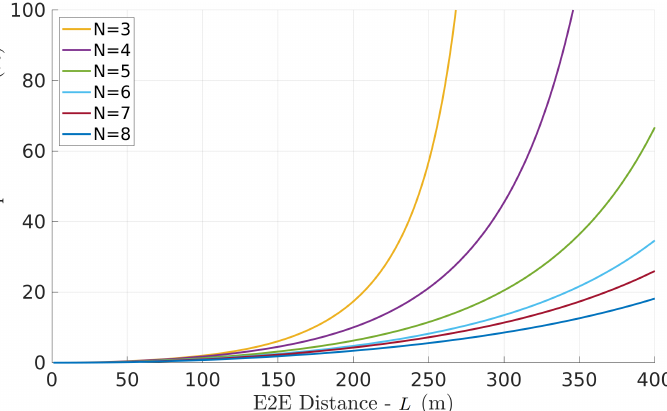
Figure 12. Average network PDR gain Φ (optimal relative to equidistant relay placement) with random link models, as a function of the number of links and network length L